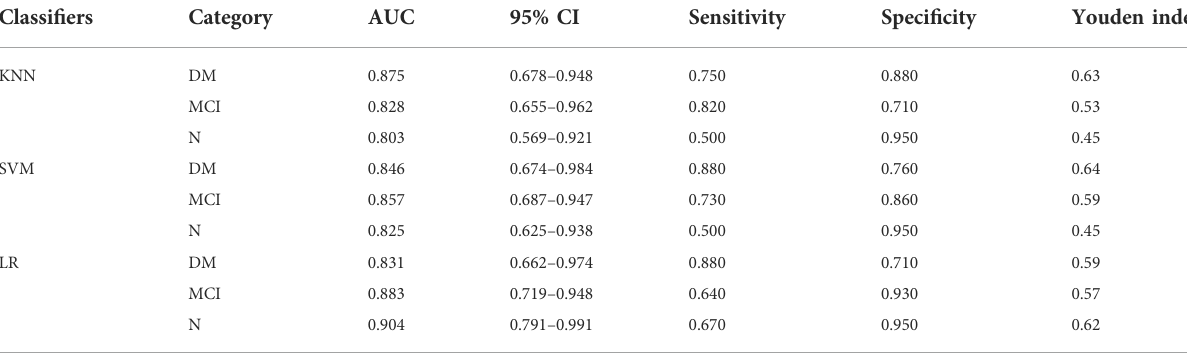
TABLE 4 The results of AUC, 95% CI, Sensitivity, and Speci fi city in the validation